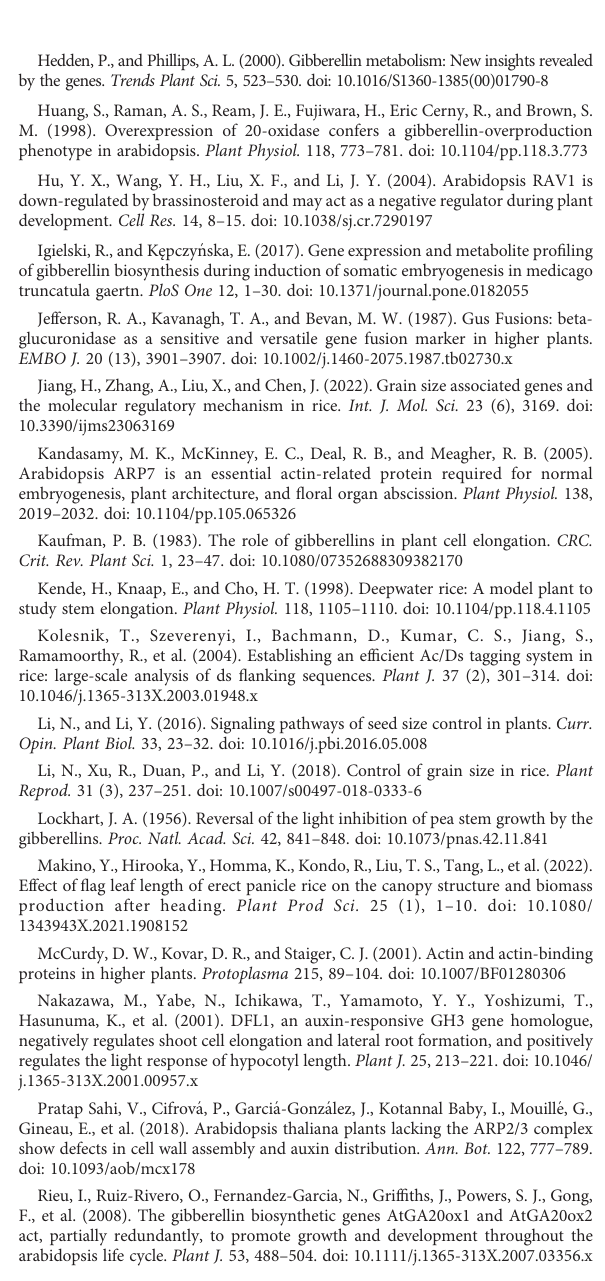
hygromycin phosphotransferase. Northern blot analysis (B) of the OsGASD gene in the transgenic rice. Red boxes mark lines 2, 4 and 7 which were used in this study. (C-E) Analysis of overexpression of OsGASD plant (Ox) and osgasd knockout mutant (Ko1) phenotypes. (C) Morphology of 10-day-old wild-type (WT), overexpression of OsGASD plant (Ox) and osgasd knockout mutant (Ko1). Comparison of plant height (D) and internode length (E) were measured of the WT, Ox plants and Ko1 mutant. Error bars indicate SD. Asterisks indicate statistically signi fi cant differences between the corresponding samples and their control (p- value<0.1, Student ’ s t-test). Scale